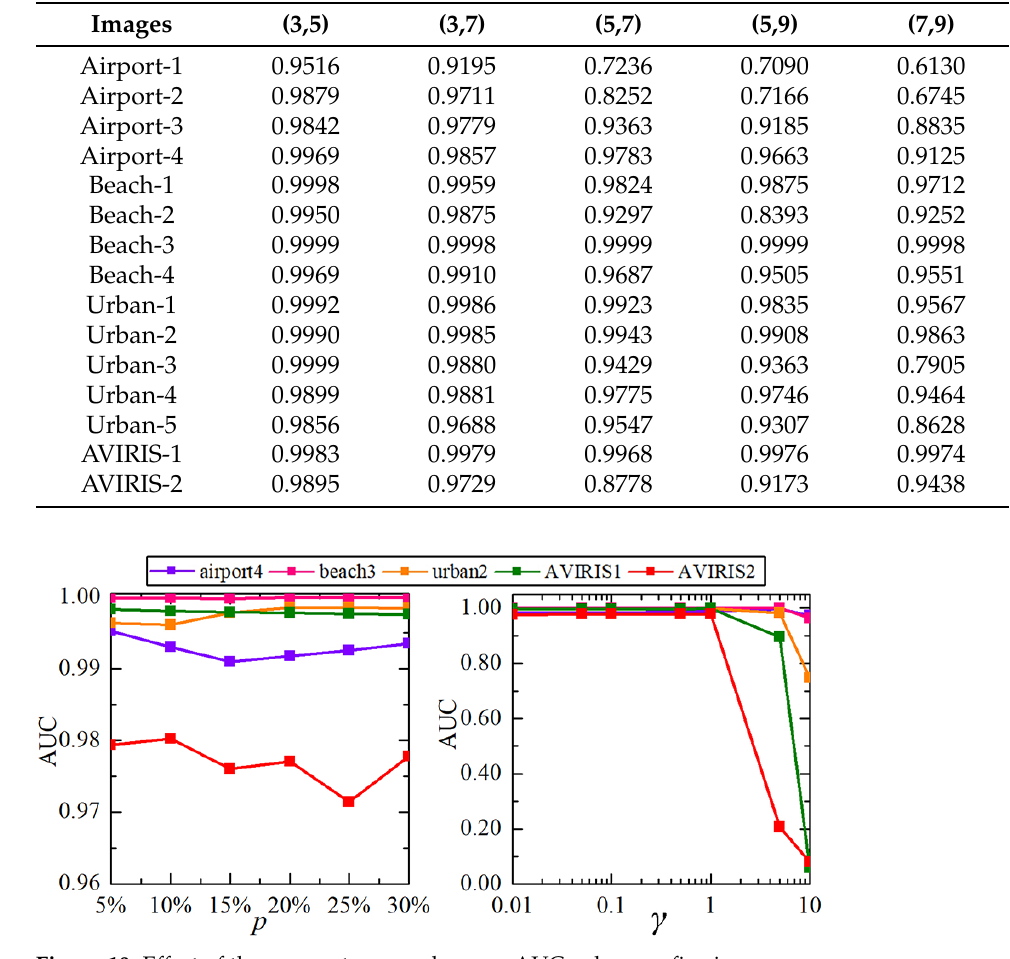
Figure 10. Effect of the parameters p and γ over AUC values on five